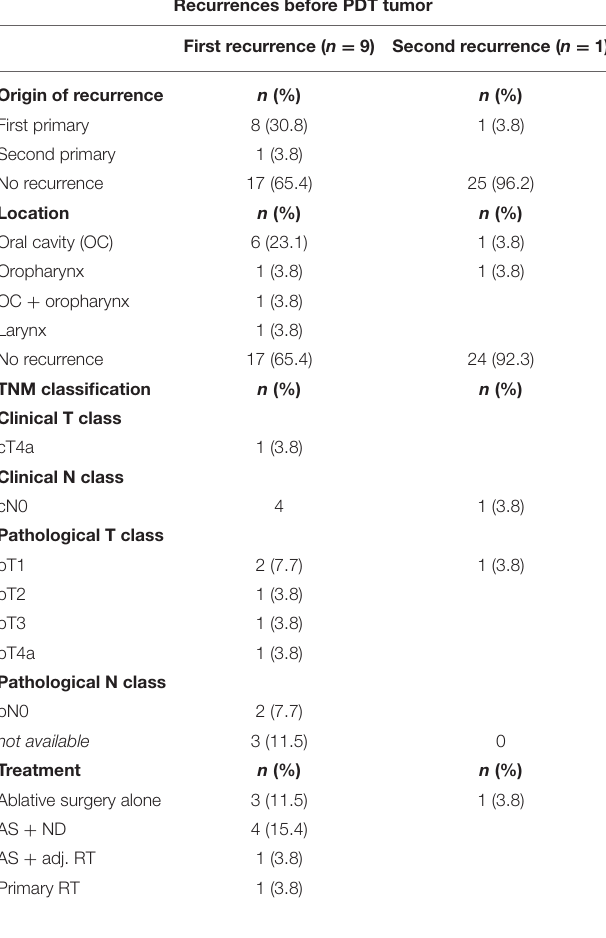
TABLE 2 | Tumor characteristics of primary head and neck SCC before diagnosis and treatment of the PDT tumor in 26 patients. Primary head and neck tumors before PDT tumor